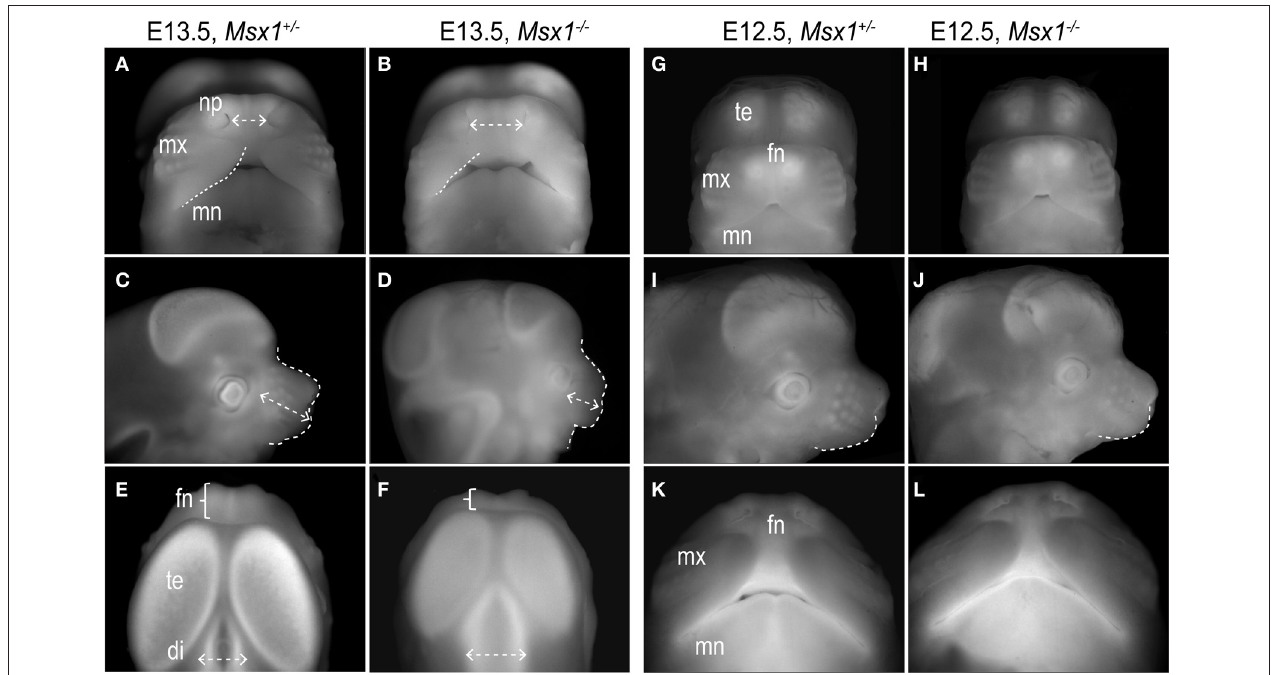
(E and F) Dorsal view of Msx1 + / − and Msx1 − / − embryos; bracket indicates size of the frontonasal prominence. Dashed arrows indicates width of the diencephalon. (G and H) Frontal view of E12.5 Msx1 + / − and Msx1 − / − embryos. (I and J) Lateral view, where dashed lines demarcates outline of the maxillary prominence. (K and L) Ventral view. di, diencephalon; fn, frontonasal prominence; mn, mandibular prominence; mx, maxillary prominence; np, nasal pit; te,